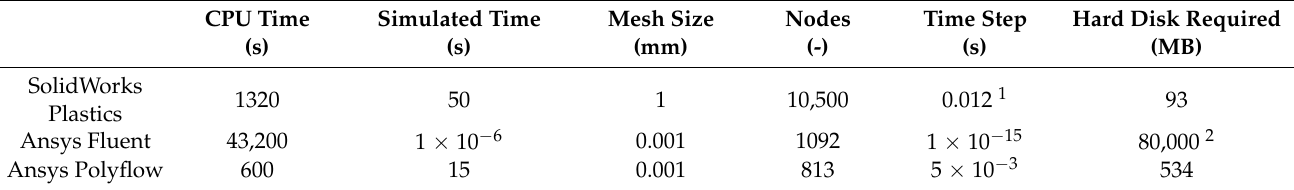
Table 4. Simulation times for Ansys Fluent versus Ansys Polyflow approach.